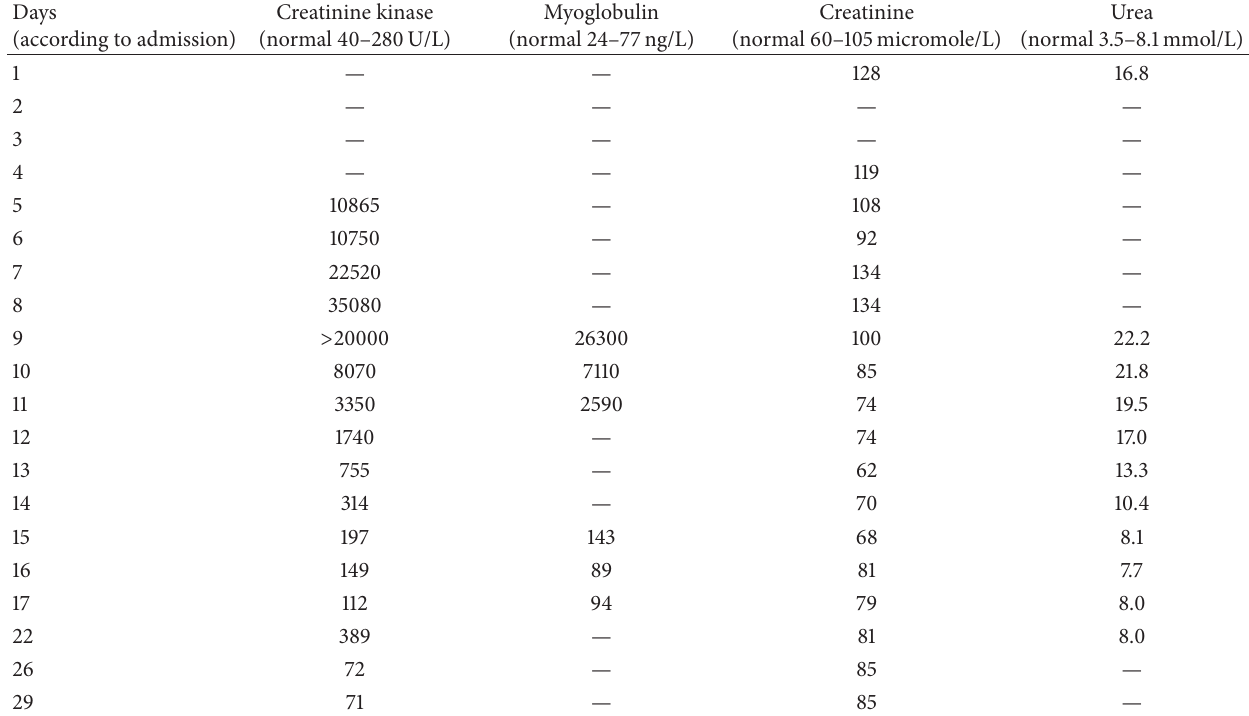
Table 1: Muscle and kidney function biomarkers during the admission. The combination of atorvastatin and fusidic acid stopped at day 6 since